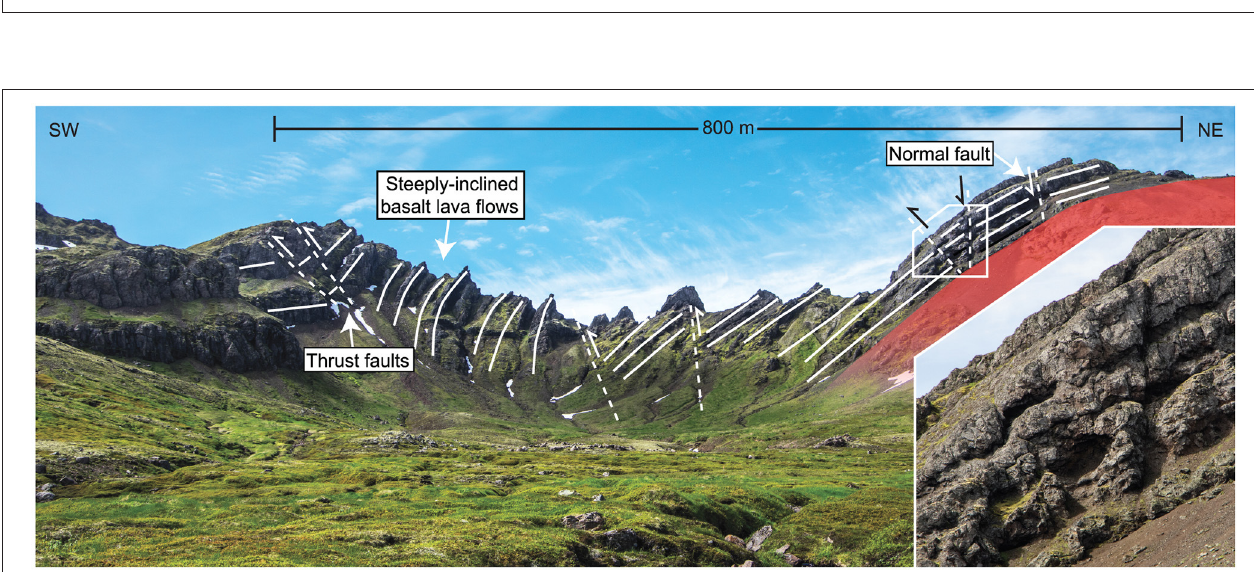
FIGURE 9 | (A,B) Photograph and interpretation of large-scale host-rock deformation at the south side of Upper Sandfell (compare with Figure 2A ). The dip of the wall rock to the Sandfell laccolith changes abruptly at reverse (thrust) faults (at the edges of the host-rock dome). The roof rocks of the laccolith (the center of the host-rock dome) display normal faults (see inset in B ). See also Figure 2C that shows a close up of an emplacement-related fault plane in the basalt host rock. The bulk of the rotation of the host rock that accommodated the Sandfell rhyolite magma occurred in relation to these faults.